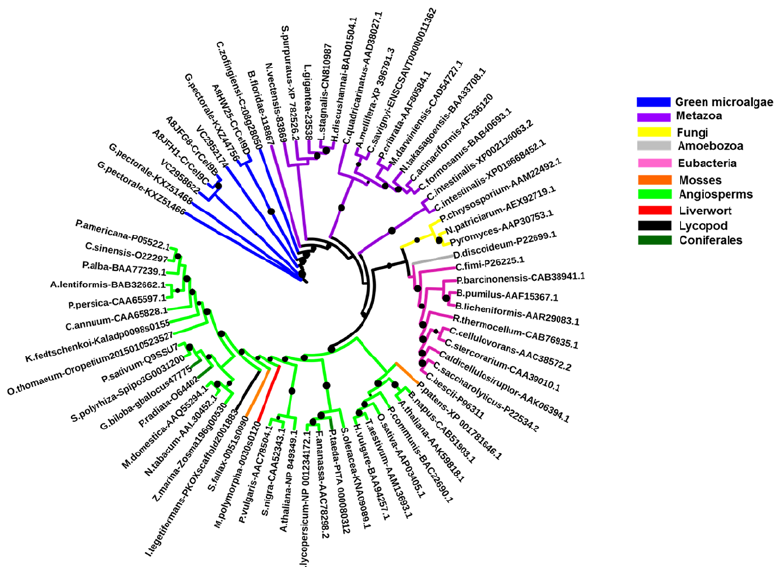
Figure 2. Maximum likelihood phylogenetic tree of GH9 cellulases (built using catalytic domains, CD in the protein sequences; see Supplementary Figure S2) from different species (100 bootstraps). The circles refer to the bootstraps (range 0.6–1; the size of the circles is proportional to the bootstrap values). The name of the species analyzed and their accession numbers are indicated in the tree. The V. carteri cellulases are indicated VC2958622 and VC2952174. The different colors represent the